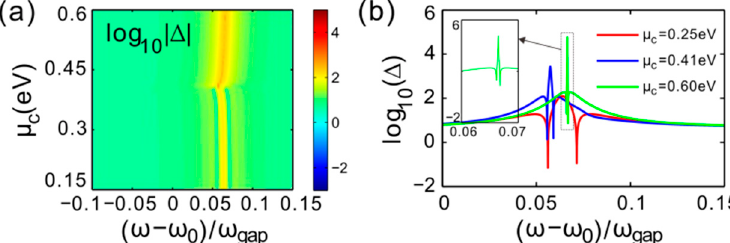
Figure 7. ( a ) The lateral shift of reflected beam in the parameter space. ( b ) The lateral shift varying with the normalized frequency. The Bragg periodic number N =